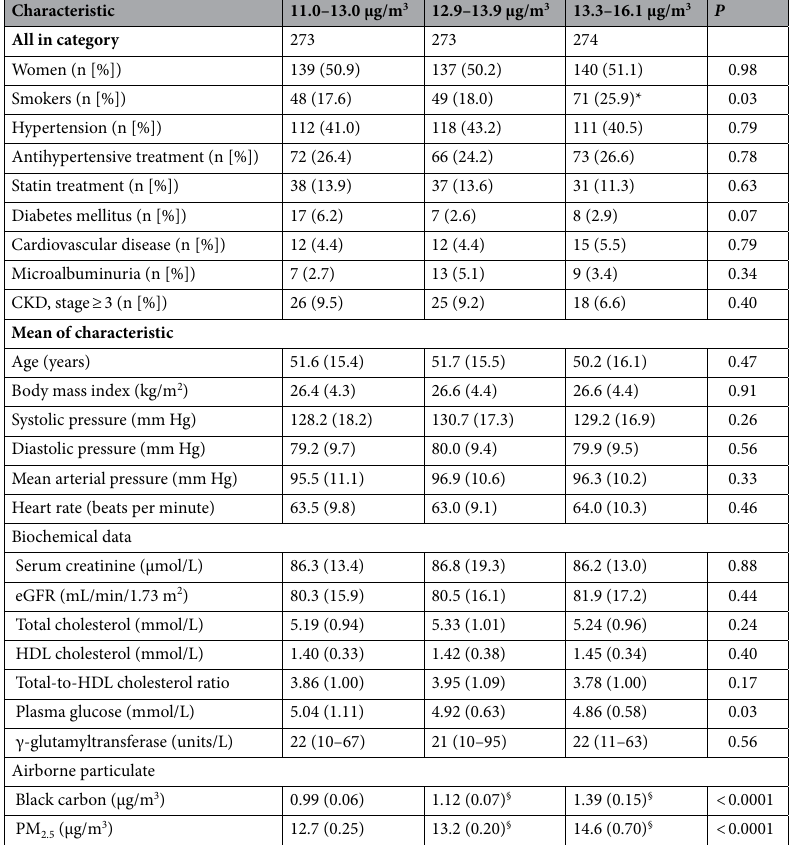
Table 2. Baseline characteristics of participants by thirds of the PM 2.5 distribution. CKD, chronic kidney disease; eGFR, glomerular filtration rate estimated from serum creatinine by the CKD-EPI formula; HDL, high-density lipoprotein. Microalbuminuria (> 3.5/> 2.5 mg per mmol creatinine in women/men) was available in 780 participants. Thirds of the PM 2.5 distribution were determined after stratification for sex and age (<